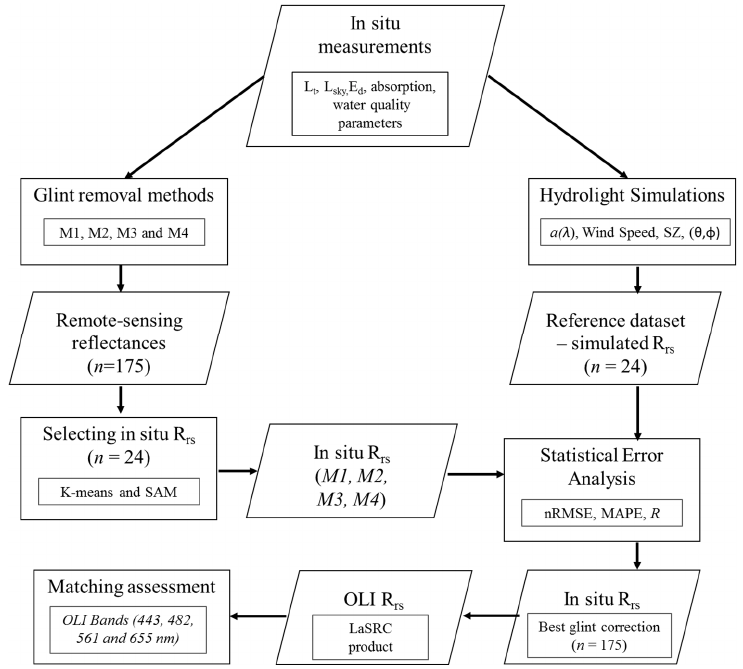
Figure 2. Methodological flowchart.